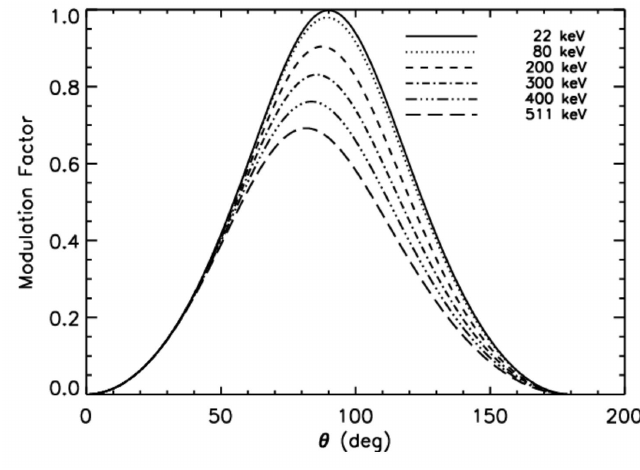
Figure 7. Modulation factor as a function of the scattering angle for different energies of the incoming photon.